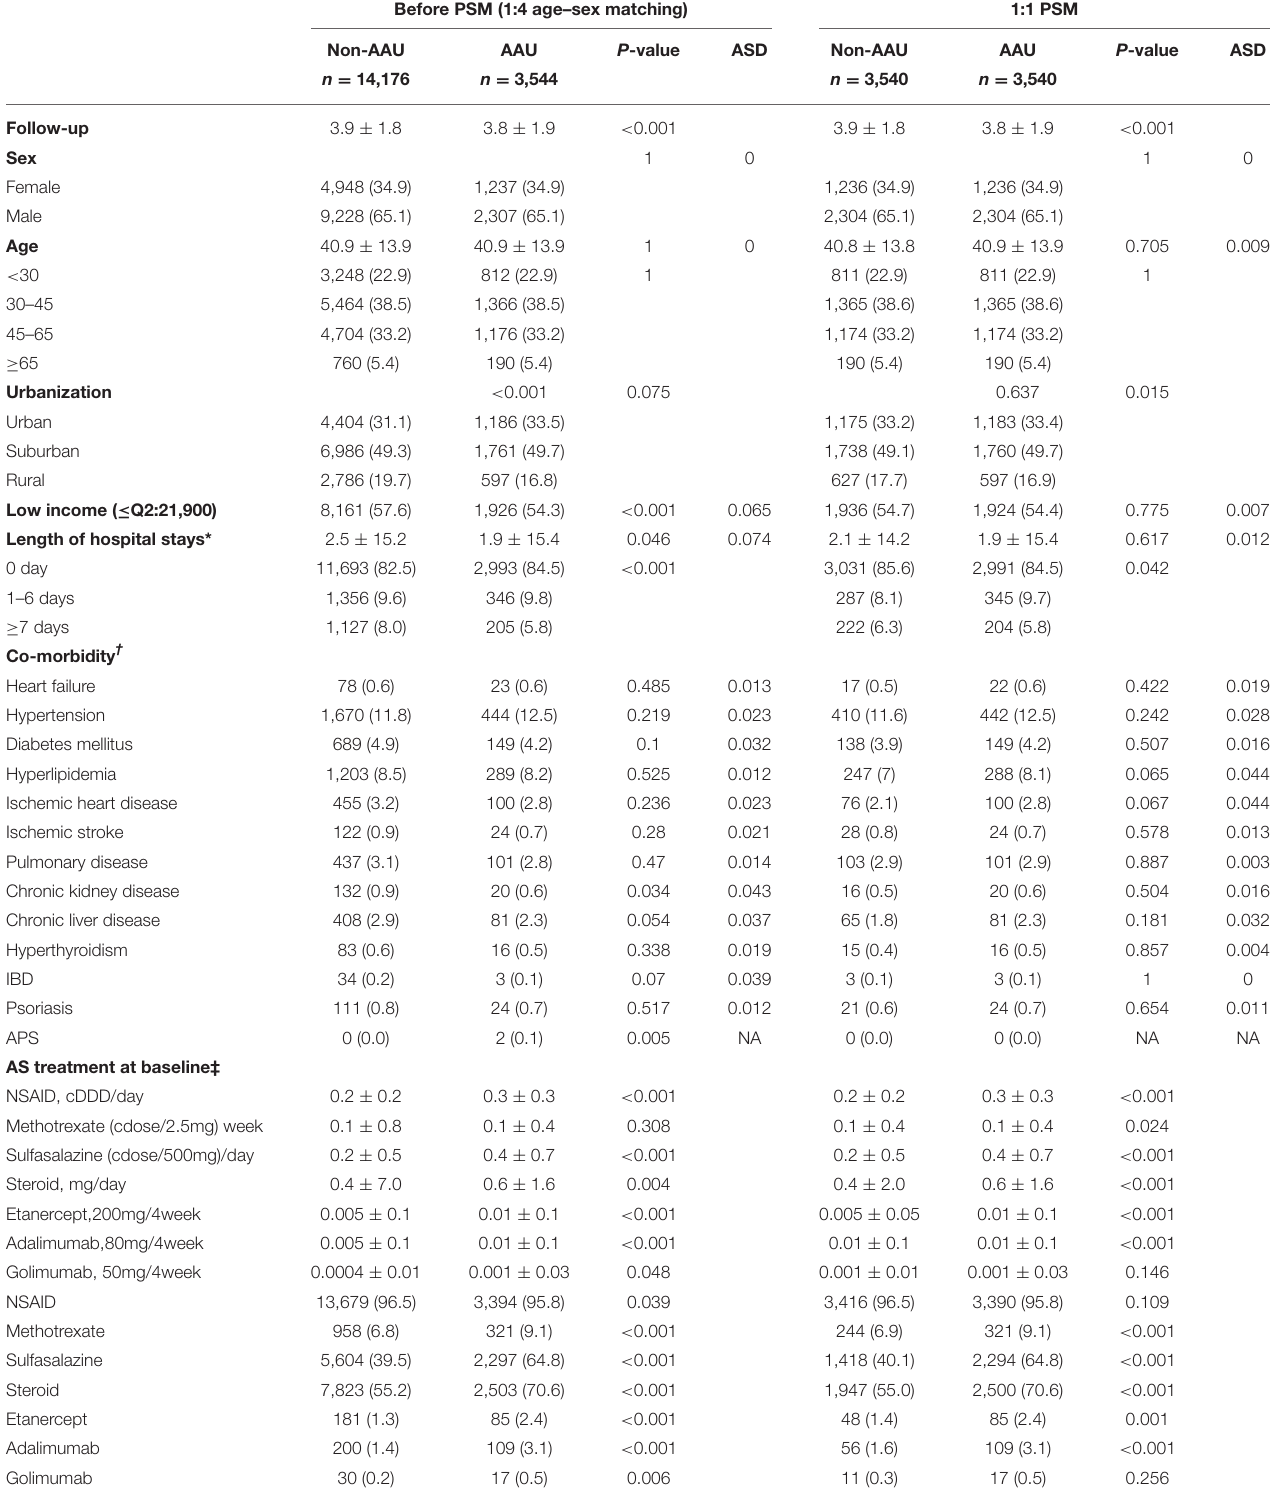
TABLE 1 | Baseline characteristics among AAU group and non-AAU group. Before PSM (1:4 age–sex